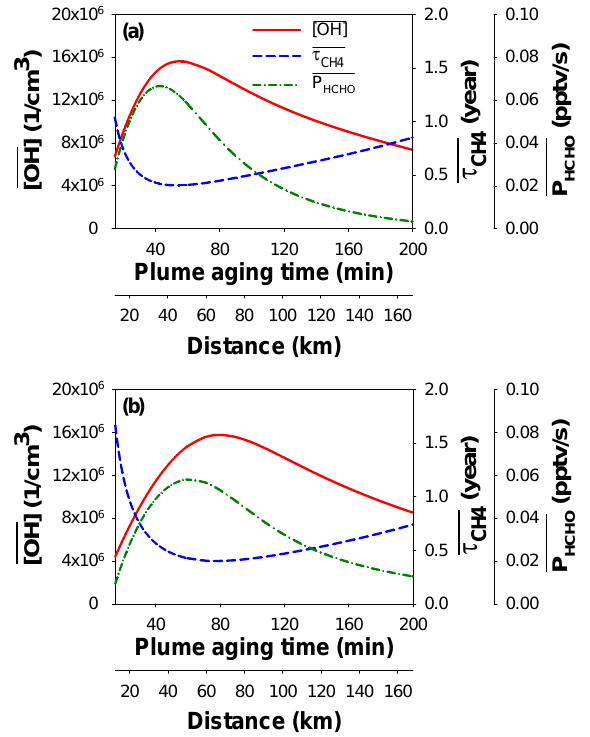
Fig. 9. Changes in the cross-section averaged OH radical concen- trations (red-solid lines), instantaneous chemical lifetime of CH 4 ( τ CH , blue-dashed lines), and net instantaneous HCHO production 4 rate ( P HCHO , green-dotted lines) with respect to ship-plume travel time (or distance) (a) under moderately stable MBL condition and (b) under stable MBL